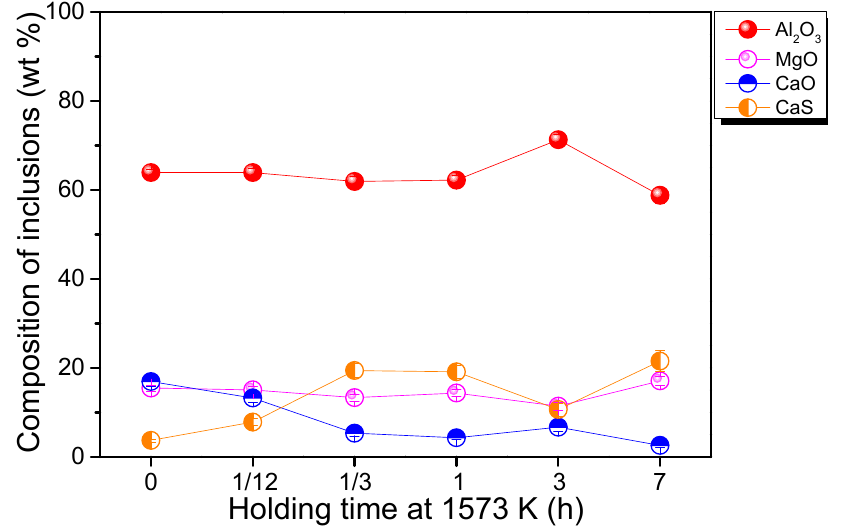
Figure 13. Effect of holding time of heating on the average composition of inclusions in the steel heated at 1573 K.